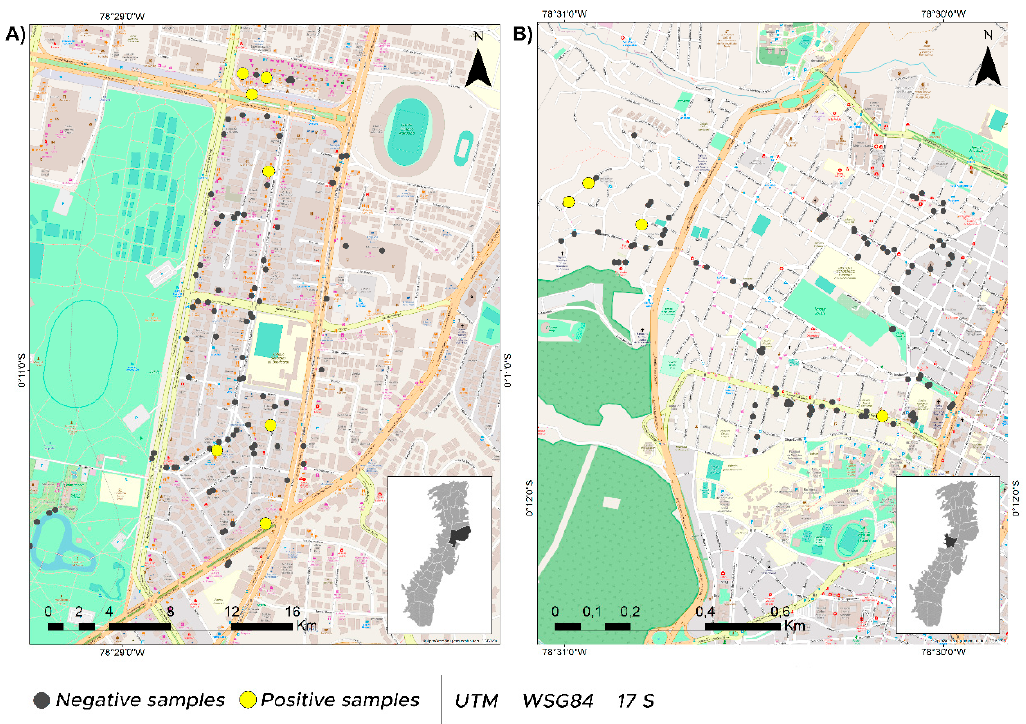
Figure 1. Sampling locations in Quito metropolitan district (DMQ), negative samples are represented with a grey dot and positive samples are shown with a yellow dot. ( A ) Iñaquito neighborhood sampling sites, ( B ) Belisario Quevedo neighborhood sampling sites. Map made with ArcGis 10.5.